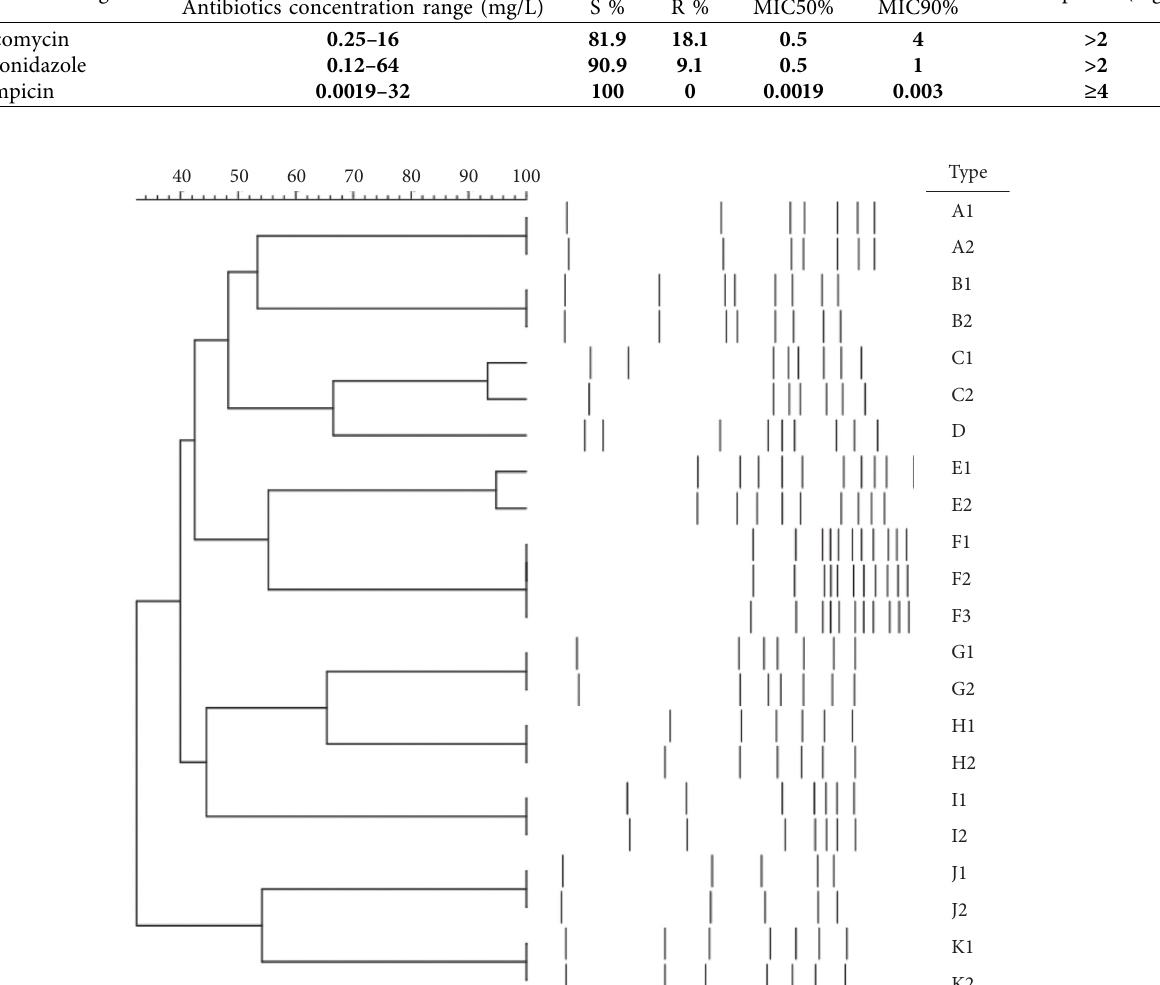
Table 4: Susceptibility outcomes of isolated Clostridium difficile by the agar double-dilution method. Antimicrobial agent